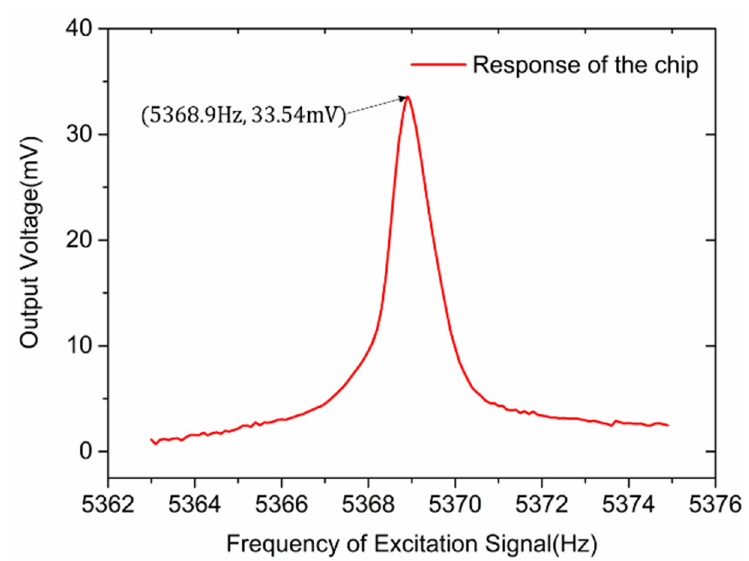
Figure 11. Amplitude–frequency response of the microsensor.